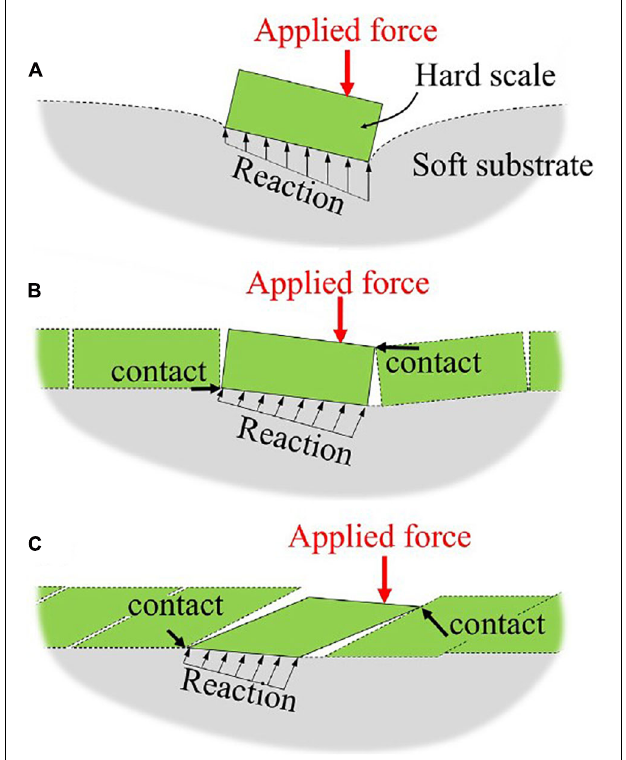
FIGURE 8 | (A) Isolated rectangular scale, (B) simple array of rectangular scales, and (C) simple array of slanted scales (Martini et al.,